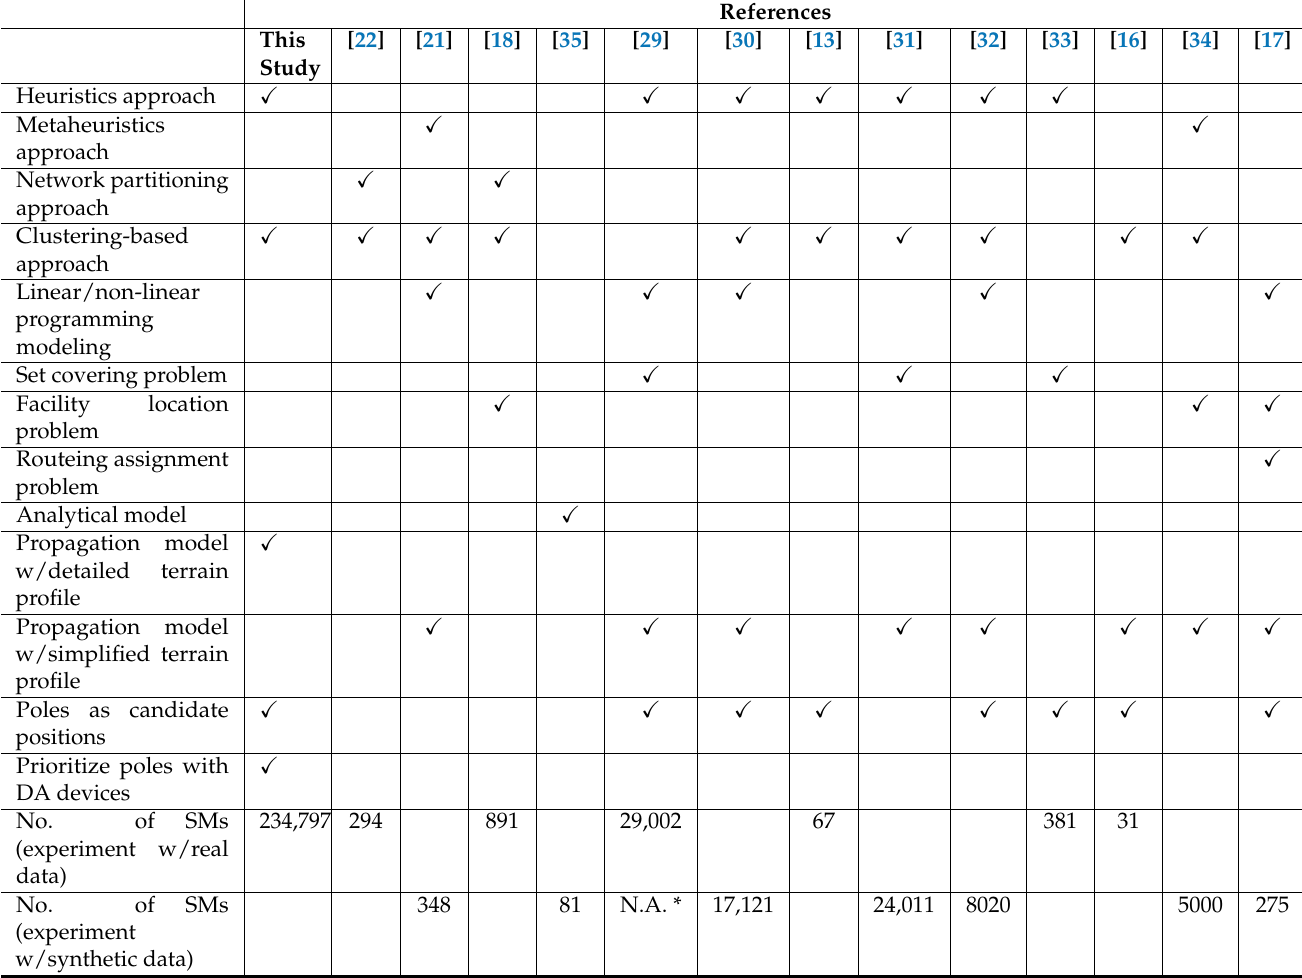
Table 1. Selected references about key devices positioning in